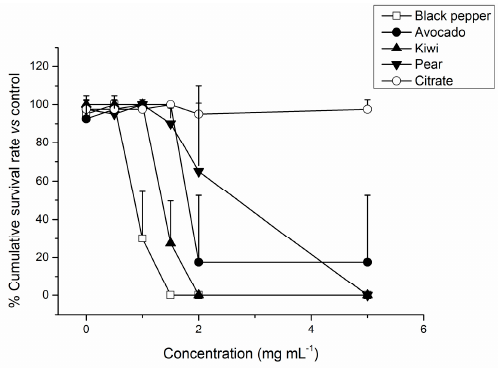
Figure 6. The cumulative survival rate of zebrafish embryos at 80 h when exposed to different concentrations of kiwi CD. Results represent the CSR mean ± SD. Statistical significance represented for t pf = 80 h. Table 3. Zebrafish embryotoxicity testing. (+) corresponds to a statistically signi fi cant e ff ect and ( − ) corresponds to a non-significant effect on tested variables.